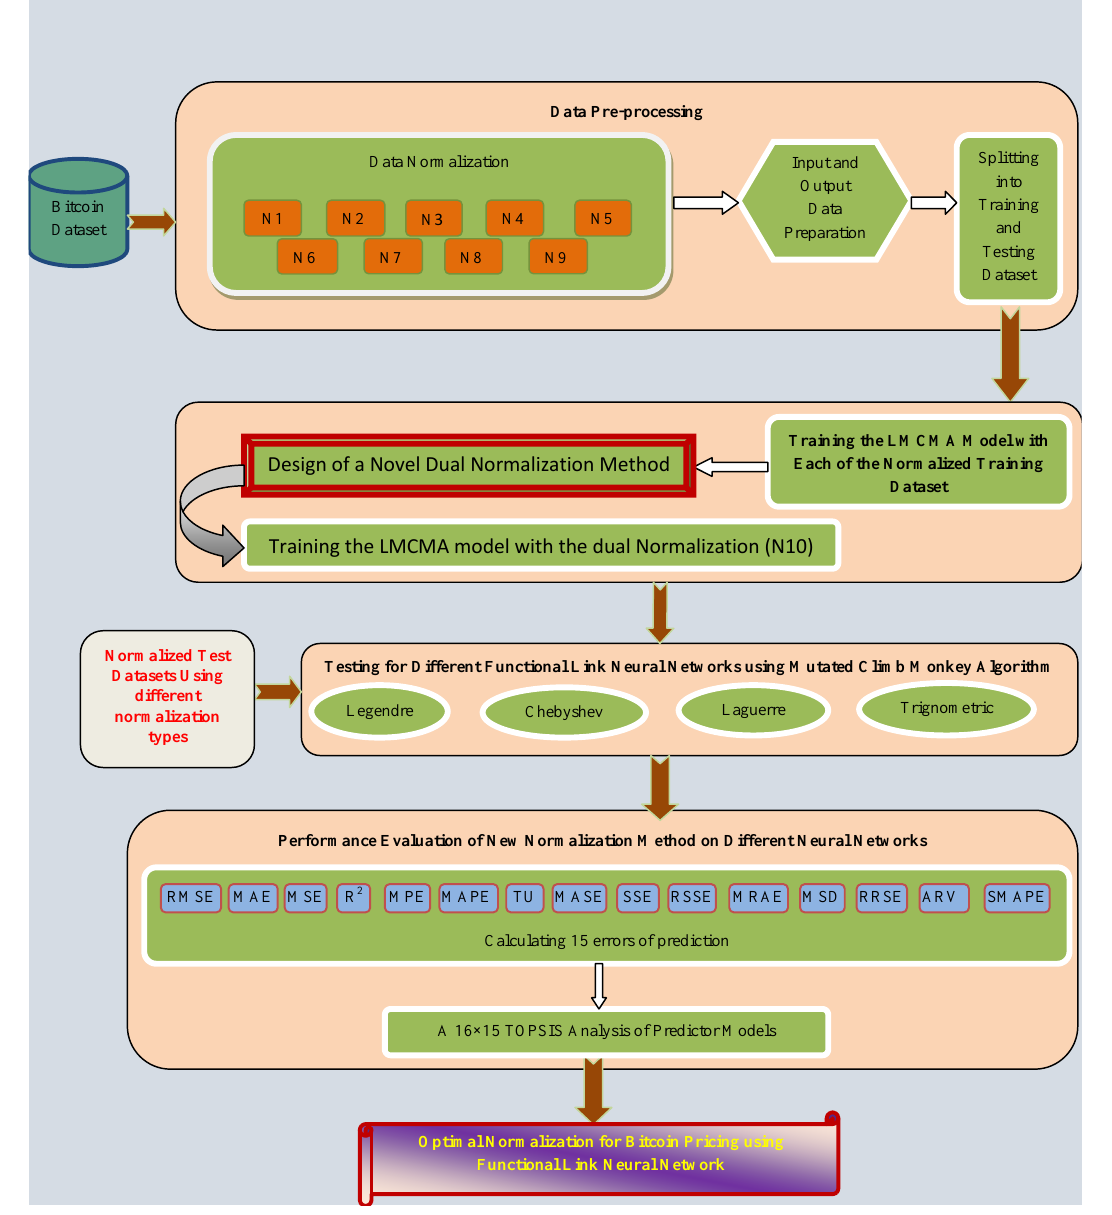
Figure 2. Proposed Work